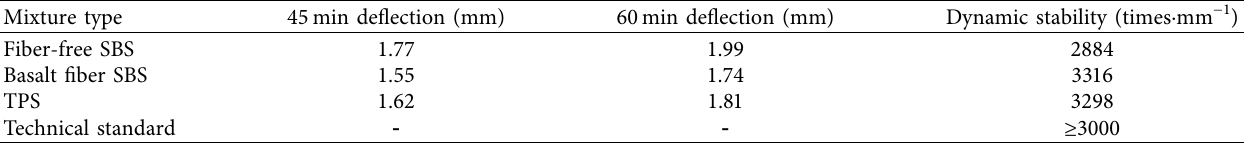
Table 12: Result of rutting